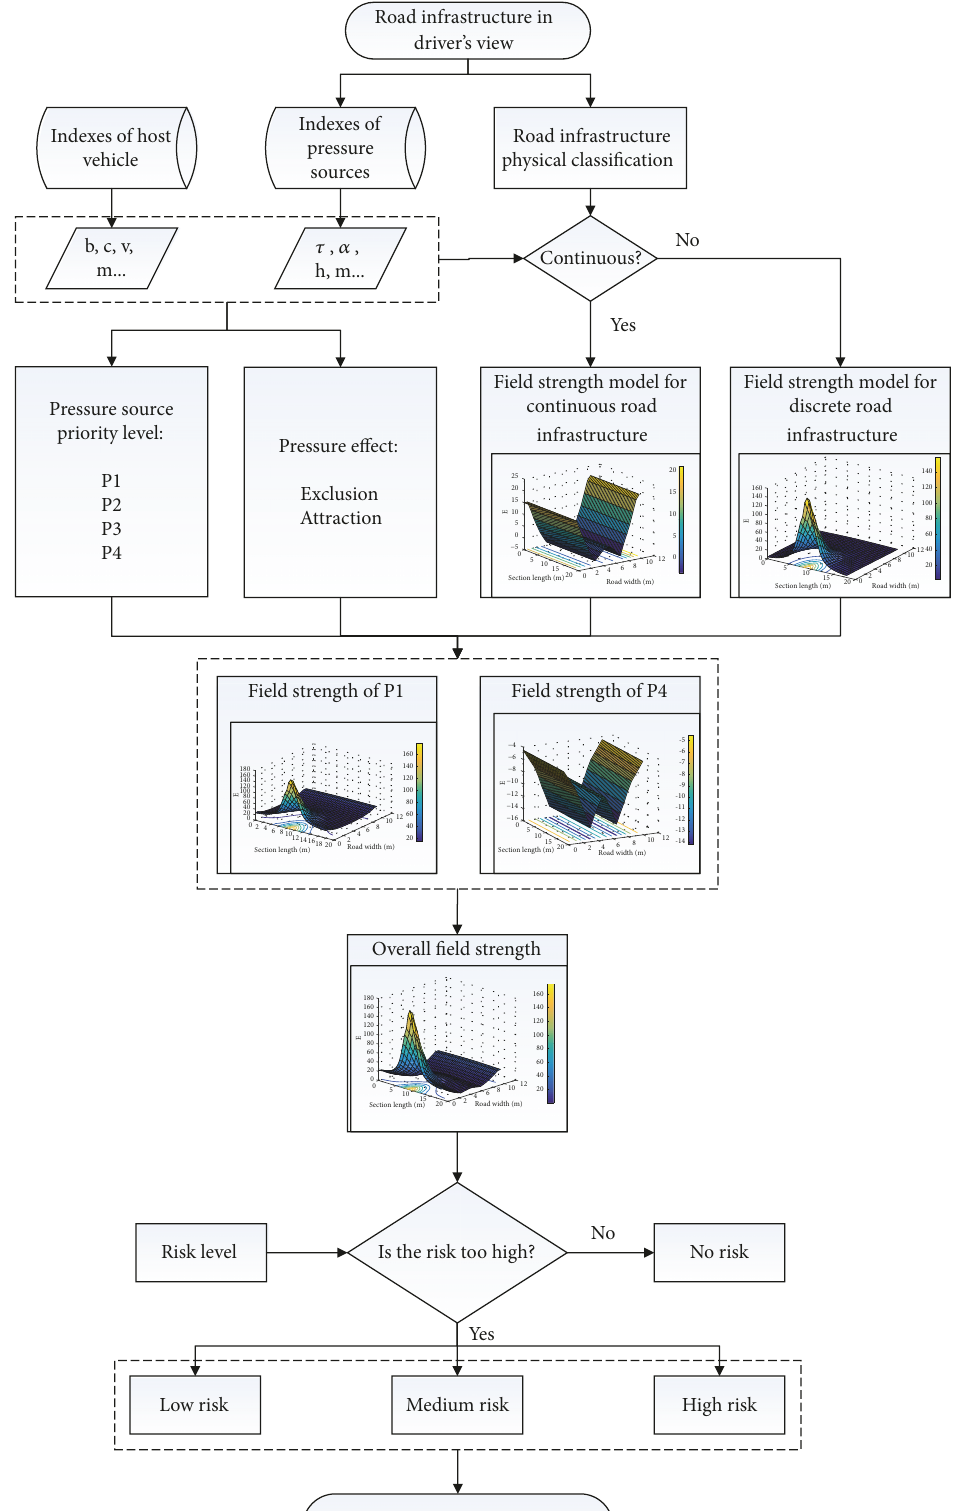
Figure 7: Workflow of road infrastructure risk assessment with test